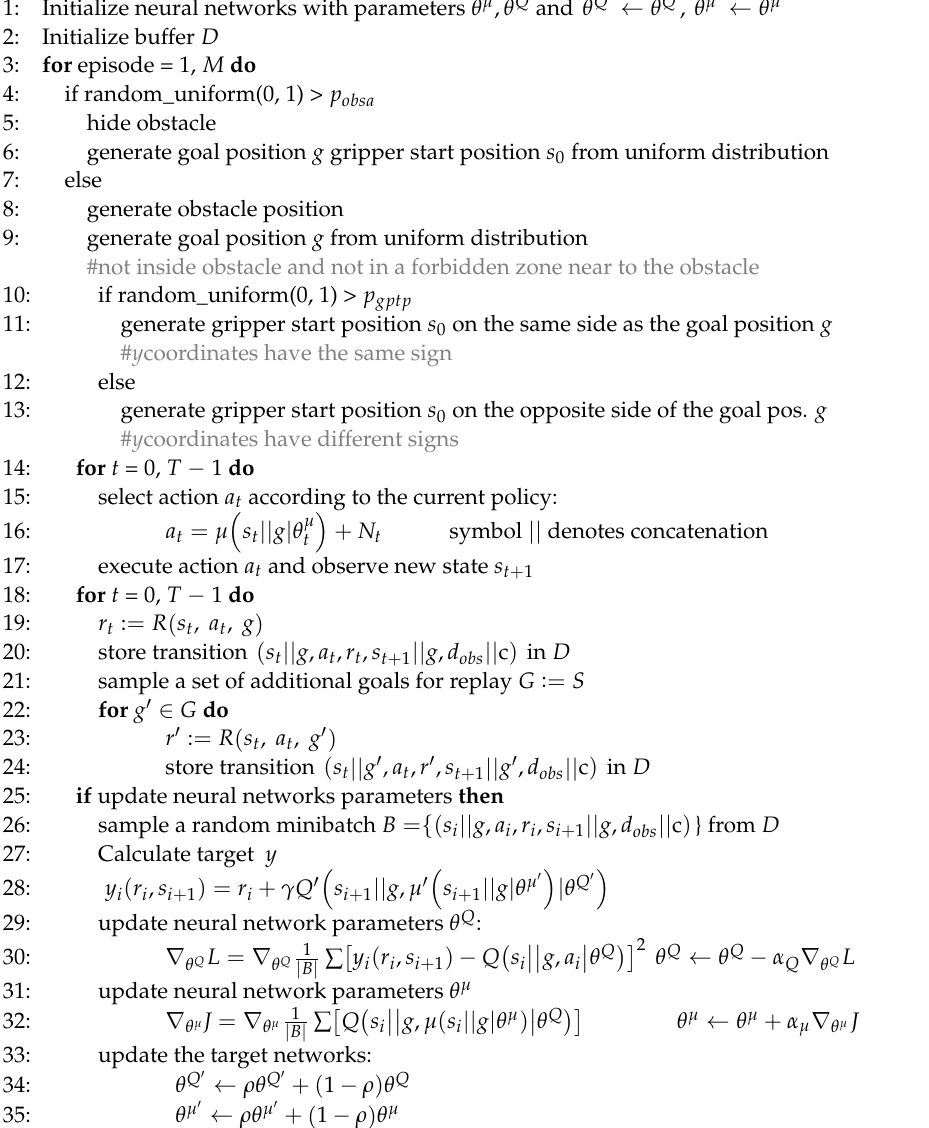
Algorithm 1. RL-based algorithm for avoiding obstacles by robotic